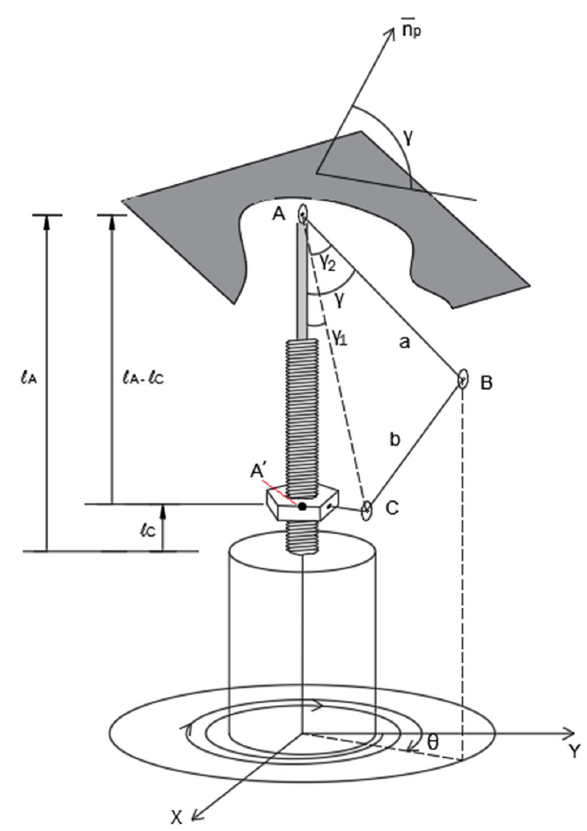
Figure 3. Schematic of the motion of the deformable polygon for the proposed heliostat.